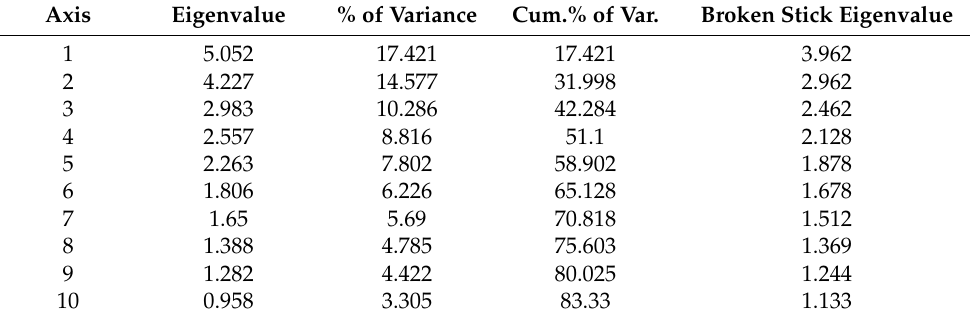
Table 1. Principal component analysis axes 1–10 summary statistics (Eigenvalue, percent of vari- ance explained, cumulative percent of variance explained, and broken-stick eigenvalue) for Basin Area Stream Survey 2010 at 9 land-use land-cover stations in the Neponset River watershed, Massachusetts, U.S.A.